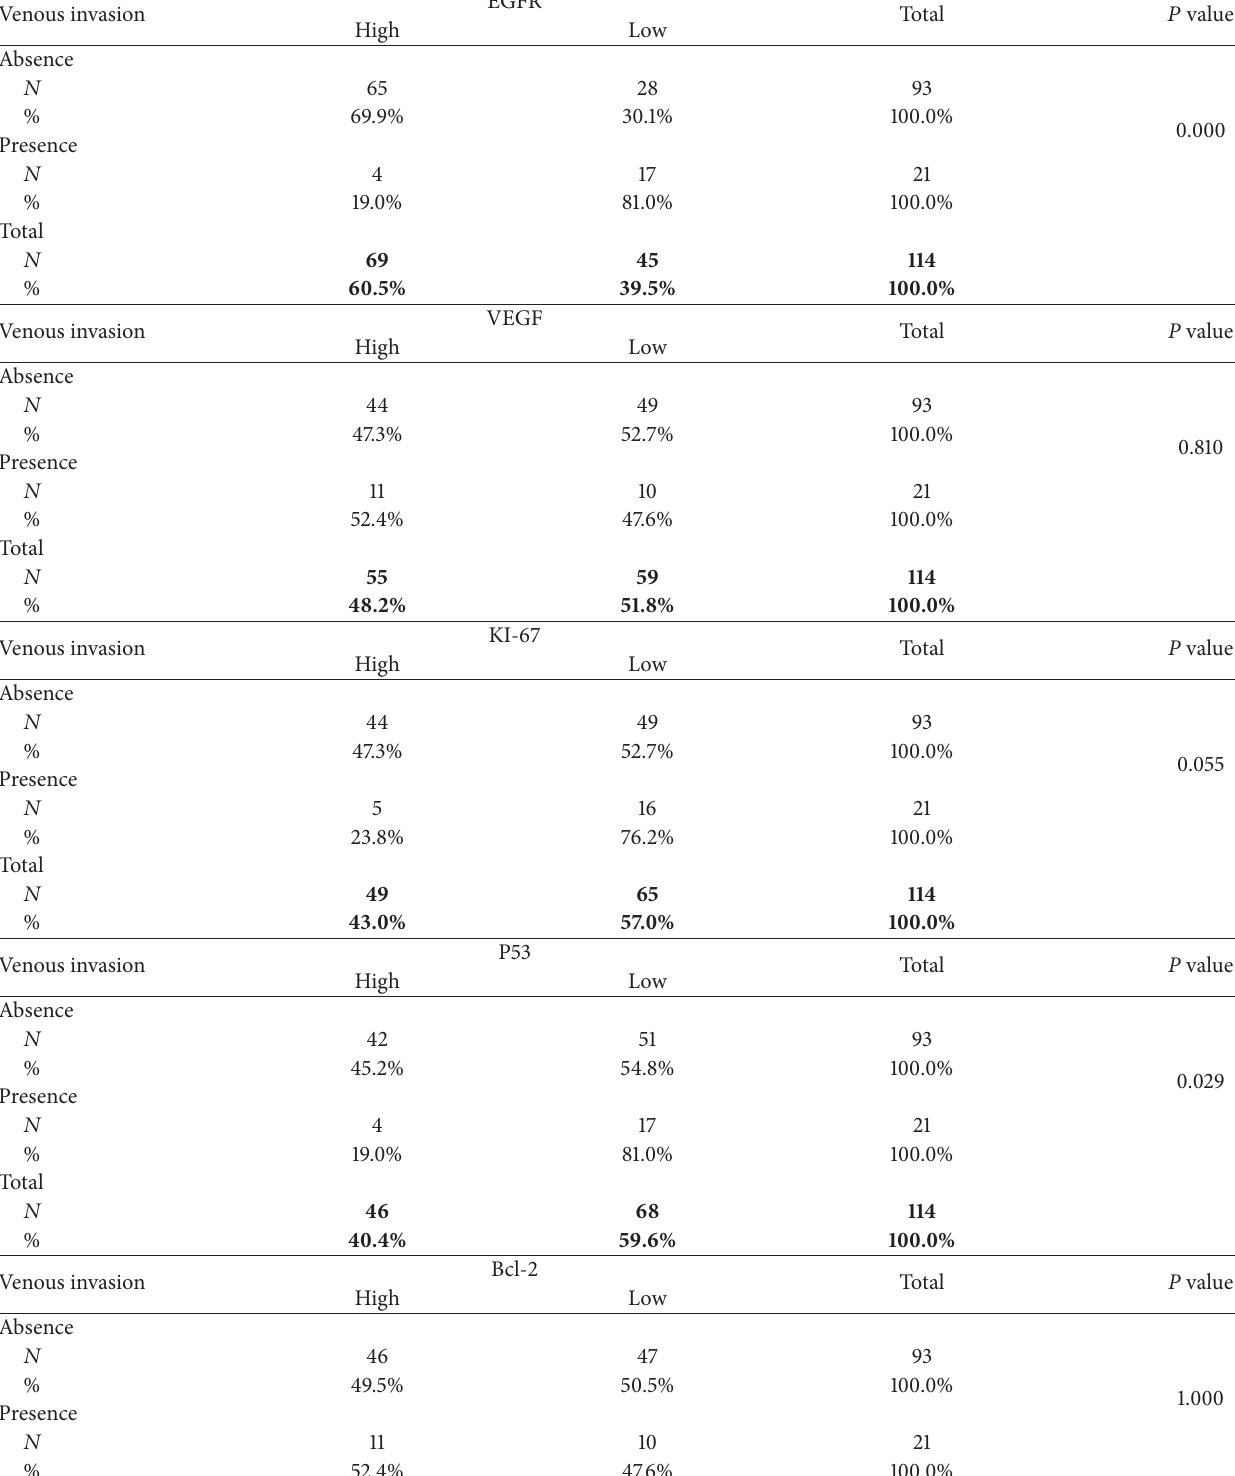
Table 6: The distribution of expression levels per IHC of proteins corresponding to ITGB-5, ITGA-3, MMP-2, and MMP9 ECM genes and FN-1 and EGFR, VEGF, KI-67, P53, and Bcl-2 molecules as per the presence of venous invasion in CRC ( 𝑛 = 114